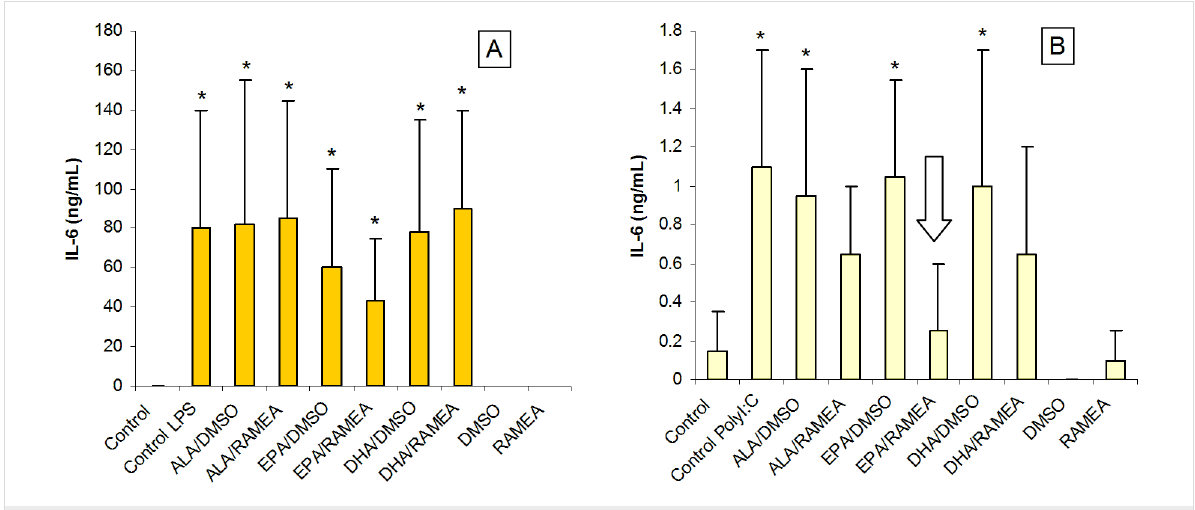
Figure 6: Effect of n − 3 PUFAs on the expression of the pro-inflammatory cytokine IL-6 in moDC activated by LPS (A) or by Poly(I:C) (B) ( N = 6) (* p < 0.05 compared to the